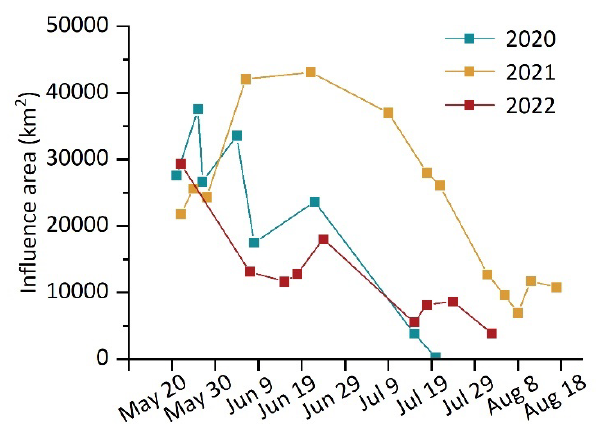
Figure 9. Statistics of the influence area of U. prolifera from 2020 to 2022.